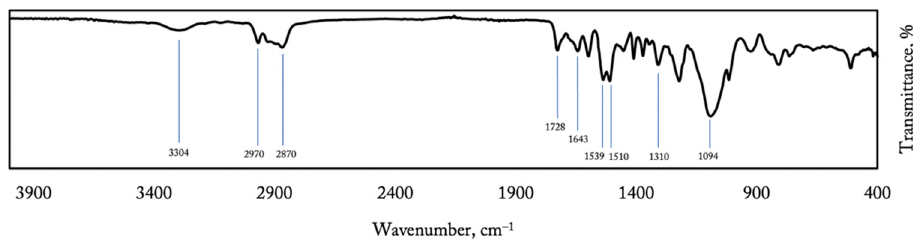
Figure 2. FTIR spectrum taken on reference sample.